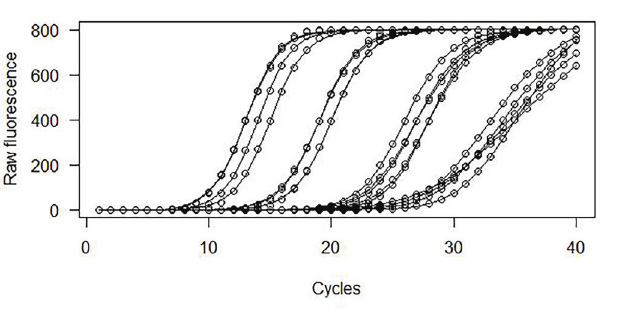
Figure 2 - Amplification of E. coli samples with 102, 104, 106,108 CFU/mL in saline